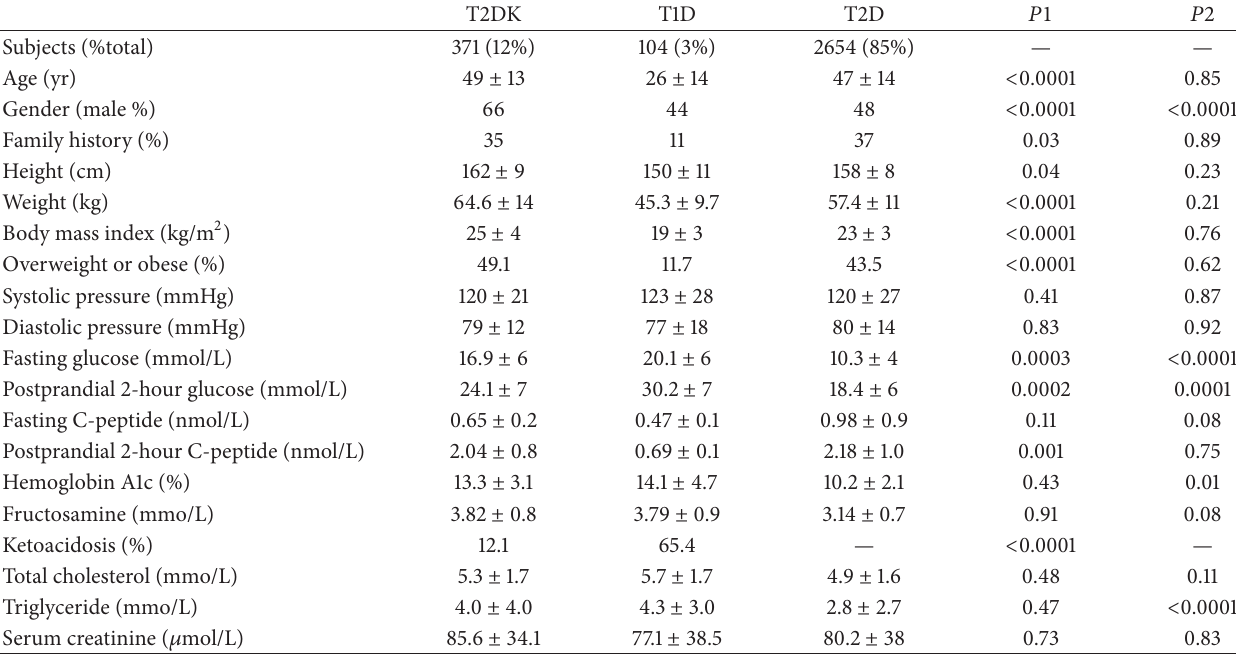
Table 1: Anthropometric and biochemical characteristics of